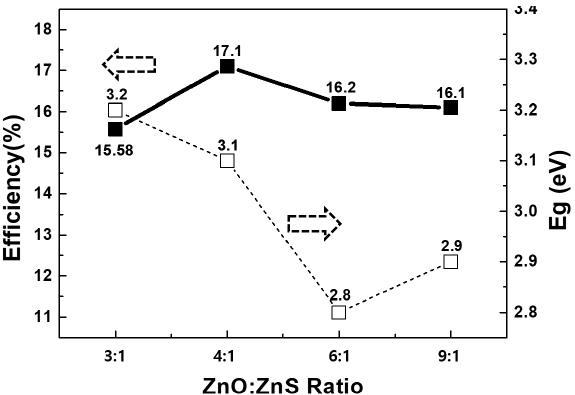
Figure 2. Cross-sectional TEM images of a CIGSSe solar cell with ALD grown Zn(O,S) buffer layer. ( a ) Magnified TEM image of the ZnO:B / Zn(O,S) / CIGS ( b ) image of grains lattice spacing